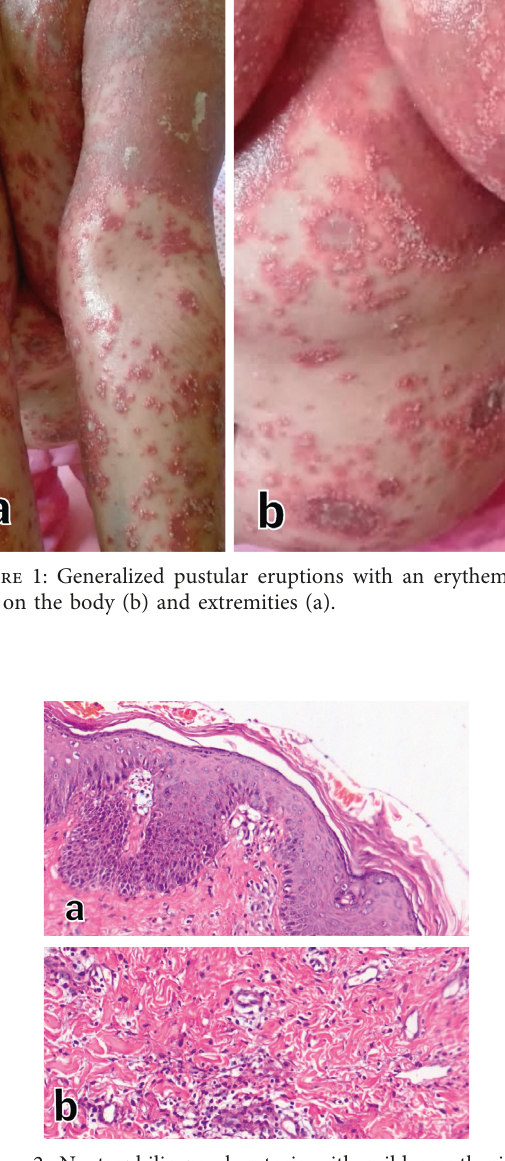
Figure 2: Neutrophilic parakeratosis with mild acanthosis and focal spongiosis, along with the scattered necrotic keratinocytes, ectatic capillaries, and perivascular interstitial lymphocytic and eosinophilic infiltration: H&E × 40 (a); H&E × 100 (b).